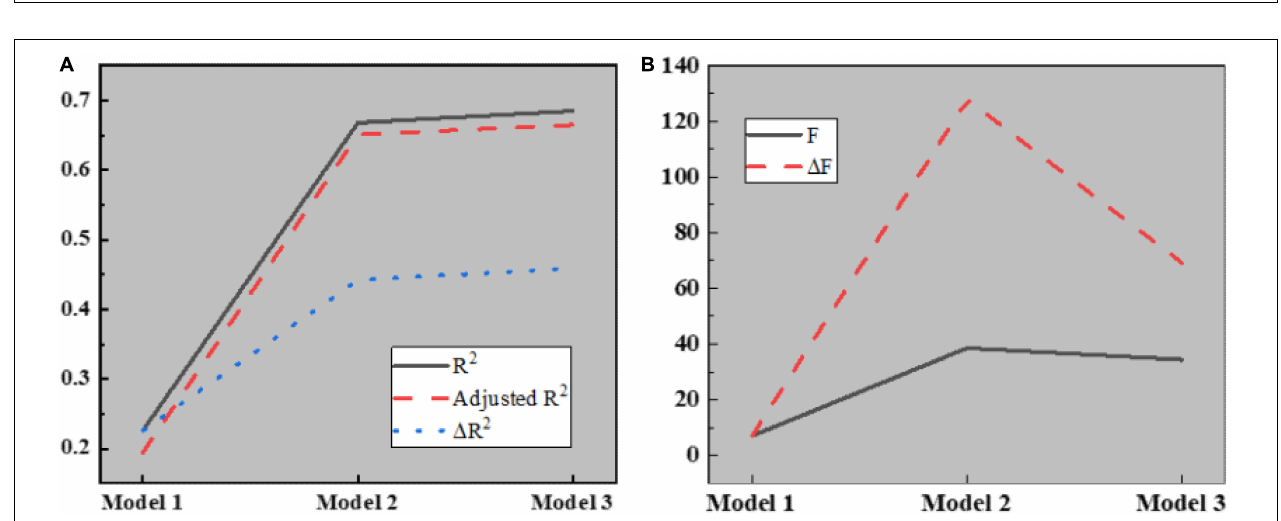
FIGURE 11 | Regression analysis results of knowledge hiding on interpersonal distrust in different models. (A) Regression model 1; (B) Regression model 2; (C) Regression model 3.